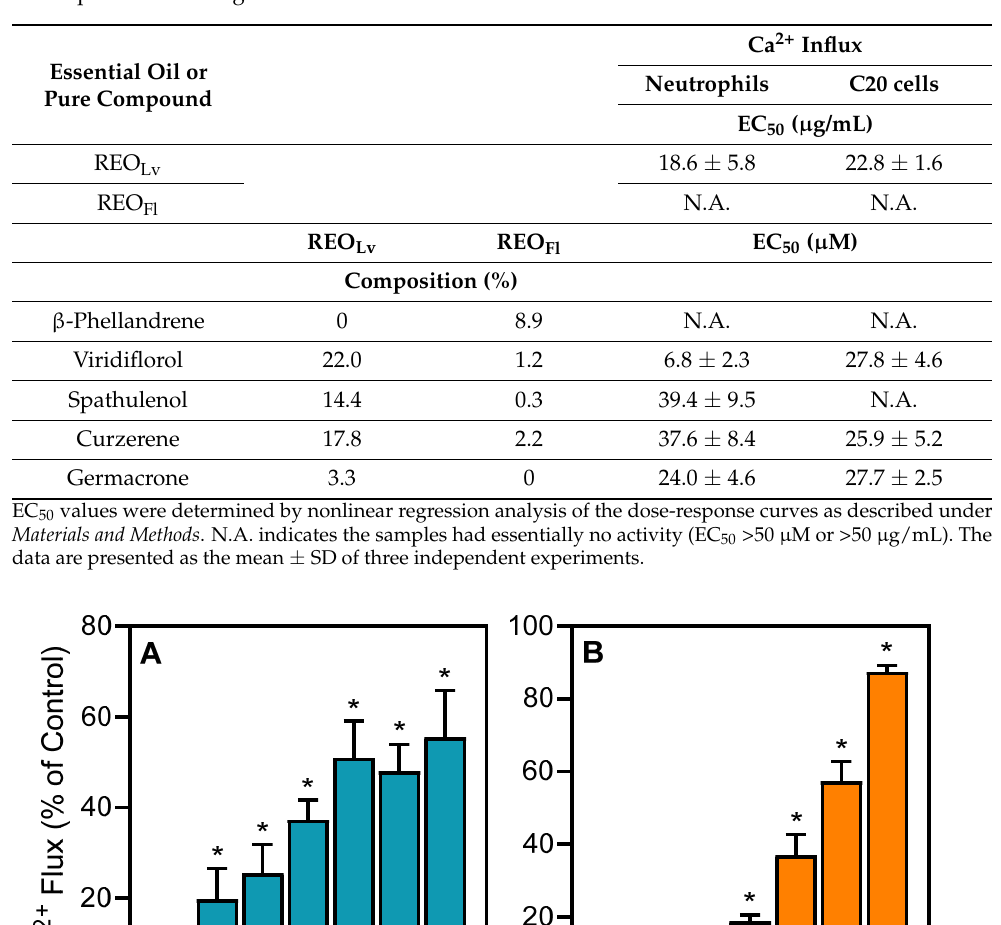
Table 4. Effect of R. albiflorum essential oils and component compounds on Ca 2+ influx in human neutrophils and microglial cells.